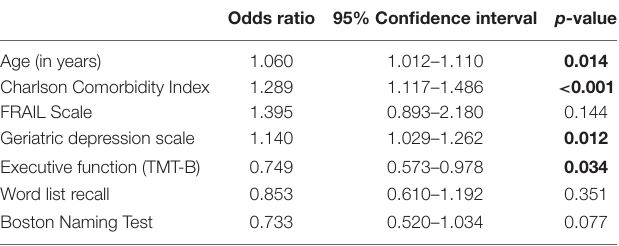
TABLE 3 | Multivariate analysis of risk factors associated with delirium symptoms.